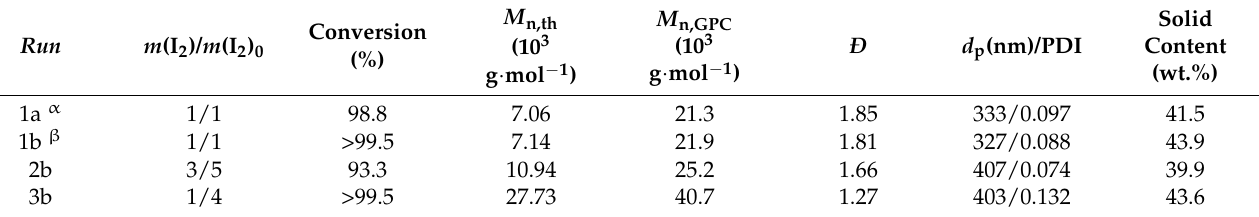
Table 11. Influence of iodine on emulsion with MMA and St units in polymer